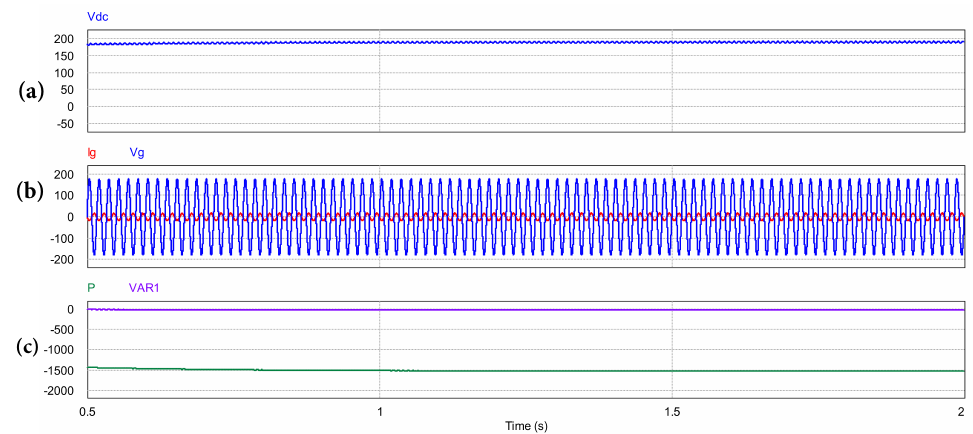
Figure 22. 1.5 kW DC-AC single phase full bridge converter, closed loop performing in rectifier mode. ( a ) DC bus voltage, ( b ) grid current (red) and grid voltage (blue) , ( c ) active (green) and reactive (purple) power.